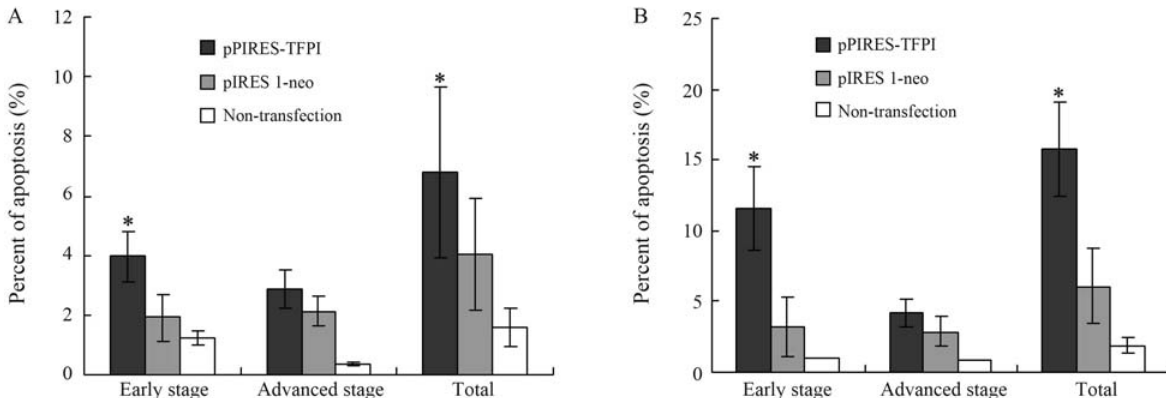
Figure 3 - Cell apoptosis analysis at the 5 th (A) and 7 th (B) days after gene transfection. * p < 0.05 in comparison to the pIRES 1-neo group or the non-transfection group (n = 8).